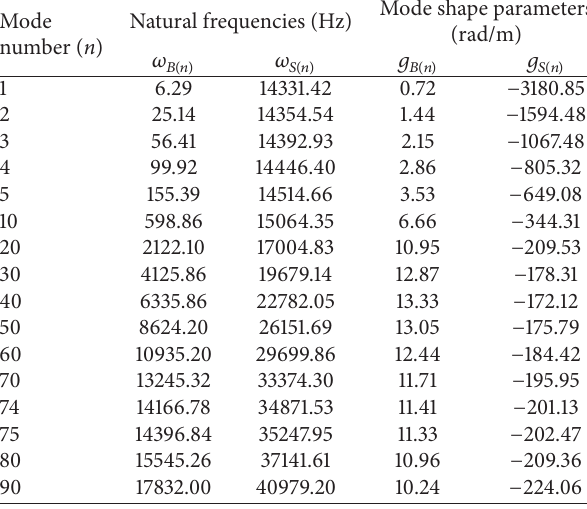
Table1:Naturalfrequenciesandmodeshapeparametersofasimply supported Timoshenko